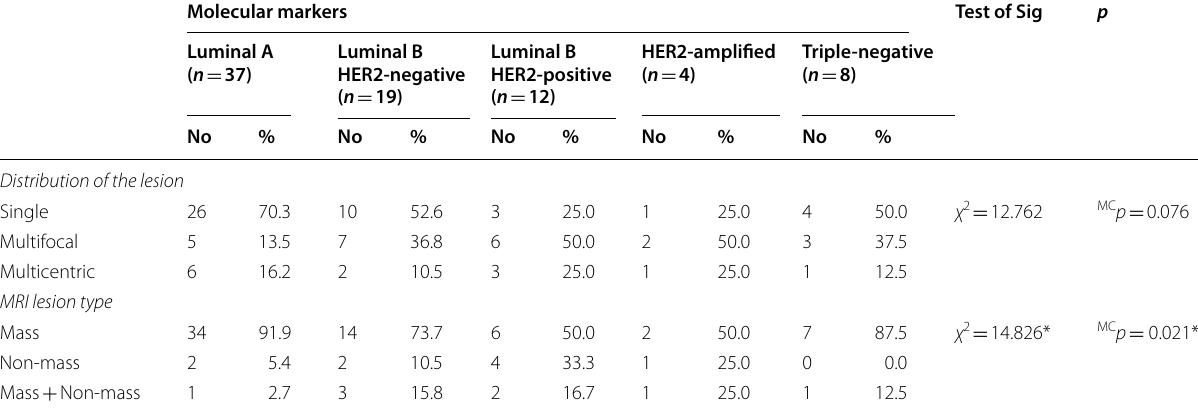
Table 4 Relation between the molecular markers and the type of the enhancing lesions and the distribution of the lesion in MRI study ( n 80) =